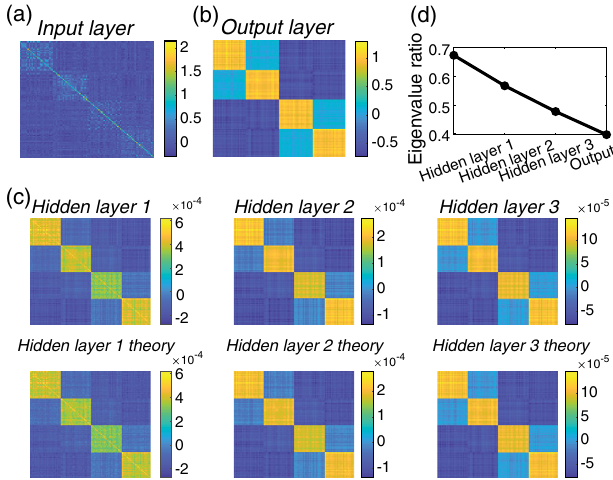
FIG. 9. Simulation and theory for the mean kernel for binary classification tasks on MNIST. The network is trained on four different MNIST digits, which are grouped into two higher-order categories (see Appendix E). The output of the network is six dimensional: Four of the output units are one-hot representations of the four digits; the other two outputs label the inputs according to their high-order category. (a) Input similarity matrix. (b) Output similarity matrix. (c) Average kernel of the hidden layer for l ¼ 1 , 2, 3. Top: simulation. Bottom: theory. (d) Ratio between the mean of the second and third largest eigenvalues (corresponding to the magnitude of the four smaller blocks) and the largest eigenvalue (corresponding to the magnitude of the two larger blocks) of the non-GP correction terms in the layerwise mean kernel, mono- tonically decreasing with l